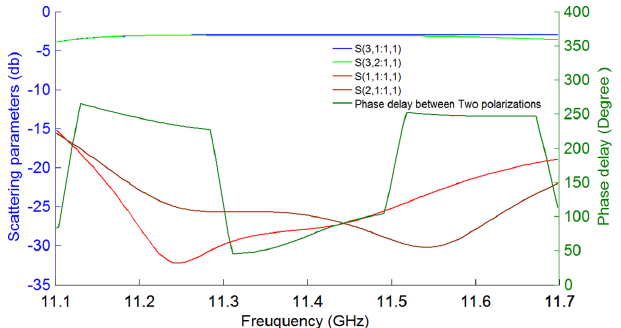
FIG. 10. Frequency spectrum of the scattering parameter and phase difference of the dual polarizers. S parameters are plotted in color code. The S(1:1,1:1), S(2:1,1:1), S(3:1,1:1) and S(3:2,1:1) are labeled in red, dark blue, brown and magenta respectively. The light blue curve shows the phase difference between two polarizations in circular